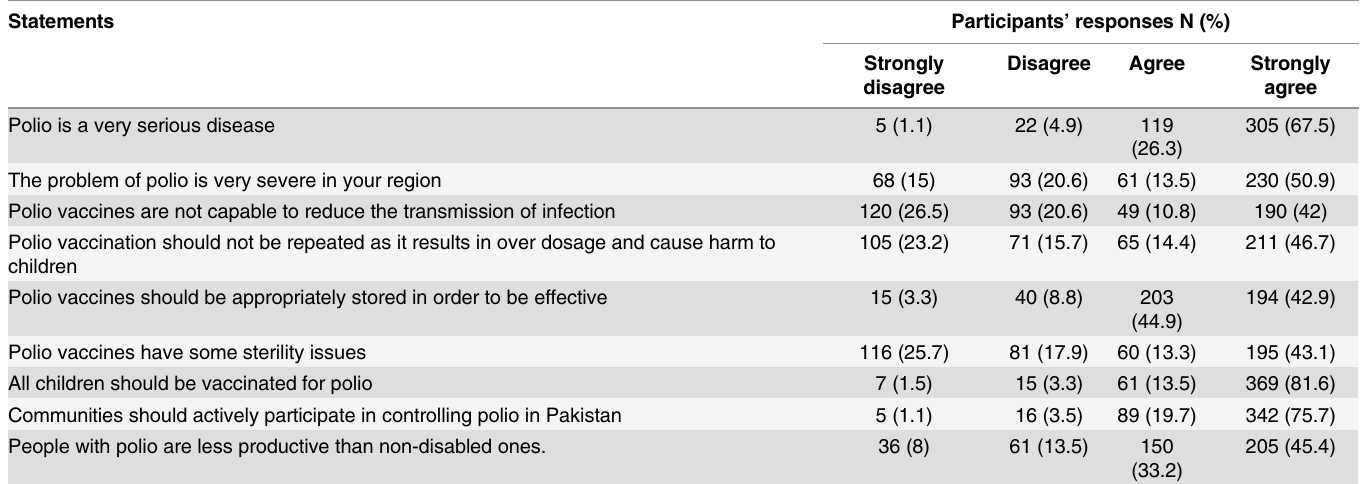
Table 4. Attitudes of participants towards polio